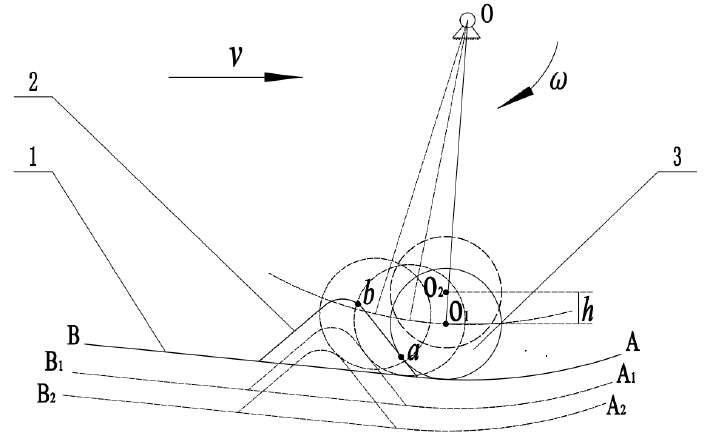
Figure 4. Schematic diagram of excitation process: (1) bar screen; (2) vibratory element; (3) vibration exciter.